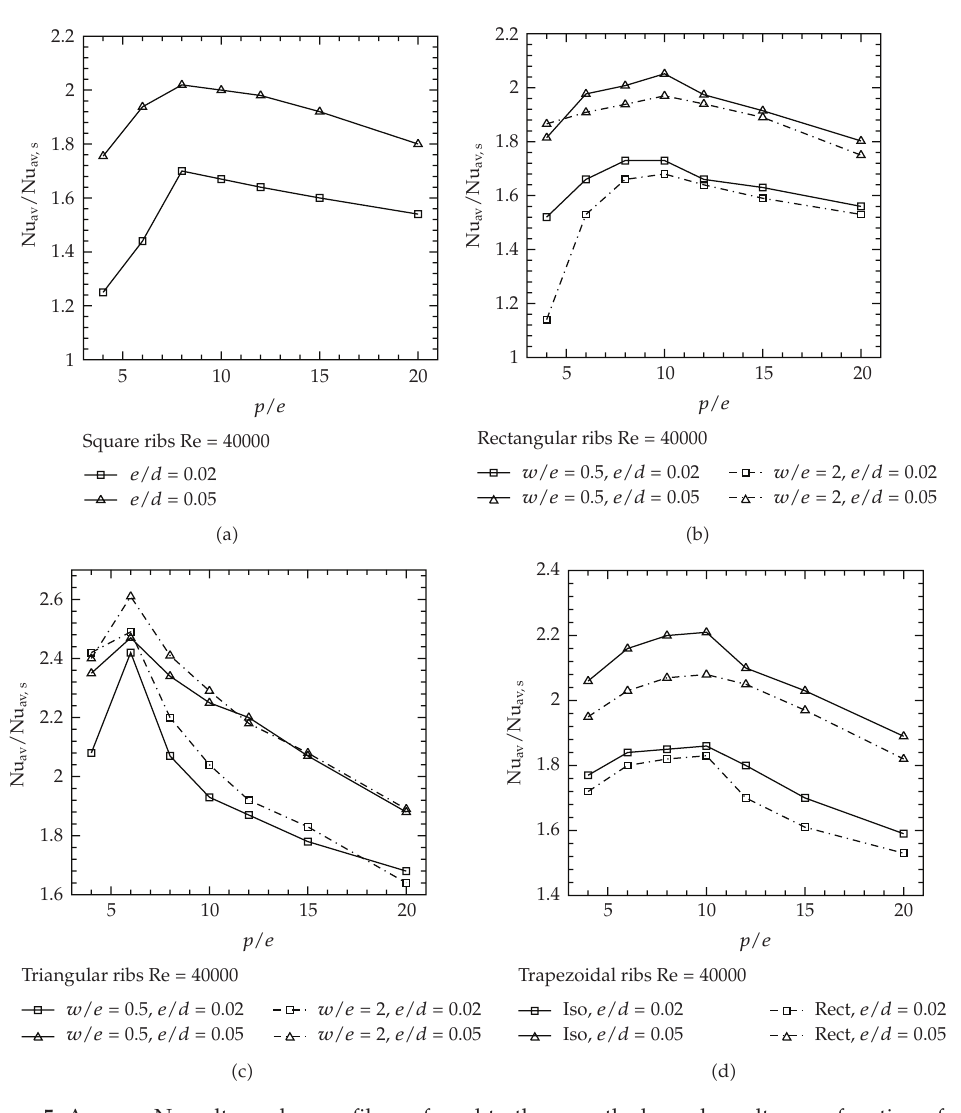
Figure 5: Average Nusselt number profiles, referred to the smooth channel results, as a function of p/e at Re (cid:8) 40000, for e/d (cid:8) 0 . 02 and 0.05: (cid:6) a (cid:7) square-ribs, (cid:6) b (cid:7) rectangular ribs with w/e (cid:8) 0 . 5 and 2.0, (cid:6) c (cid:7) triangular ribs with w/e (cid:8) 1 . 0 and 2.0, and (cid:6) d (cid:7) isosceles and rectangular trapezoidal ribs with w/e (cid:8) 2 .